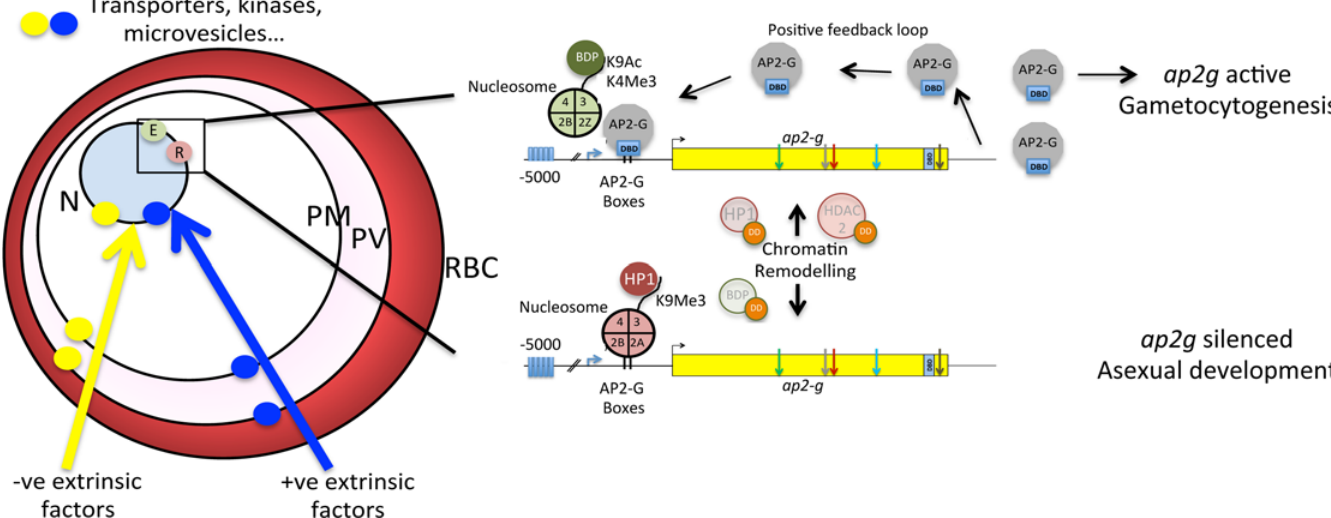
Fig 1. AP2-G: Scalable and bet-hedged epigenetic control of the master regulator of gametocytogenesis. Left panel: Cartoon of a malaria parasite- infected erythrocyte, showing the different compartments that are established by the parasite (PV, parasitophorous vacuole; PM, plasma membrane; N, nucleus; RBC, red blood cell), possible locations of hypothesised transporters, and kinases responding to environmental cues (e.g., microvesicles) that might subsequently influence (either positively or negatively) the gene expression/epigenetic status of variantly transcribed genes and the location of such genes at the nuclear periphery in distinct complexes and locales according to their transcriptional status (green, transcribed; red, silenced). Right panel: The yellow box represents the gene ap2-g , which encodes a DNA-binding transcription factor. The positions of the inactivating mutations, characterised in different lines of P . berghei that cannot produce gametocytes, are indicated. The known histone modification status and nucleosome composition associated with active and inactive genes are indicated and either inferred for this gene from evidence drawn from studies on var gene expression or (in)directly from epigenetic regulation and chromatin surveys. Thus, the association of HP1, which binds to H3K9me3 with inactive chromatin and silencing of ap2-g , is indicated, as is the association of HDAC2 activity with the generation of the active epigenetic mark, H3k9Ac. The bromodomain protein, which binds KAc in histone tails associated with active chromatin, is hypothesised here to be involved in regulating activity, but no data currently is in the public domain to support this. These three proteins have been conditionally degraded after being tagged with the shield-responsive degradation domain (DD) leading to chromatin remodelling and silencing or activation of ap2-g , as indicated. The proposed positive feedback loop is indicated, which explains AP2-G autoregulation, whereby AP2-G binds to its own cognate DNA-recognition motifs, which are upstream of the ap2-g gene in both P . berghei and P falciparum . DBD, DNA-binding domain; HP1, heterochromatin binding protein 1; BDP, bromodomain protein; HDAC2, histone deacetylase 2; DD, shield-regulated degradation